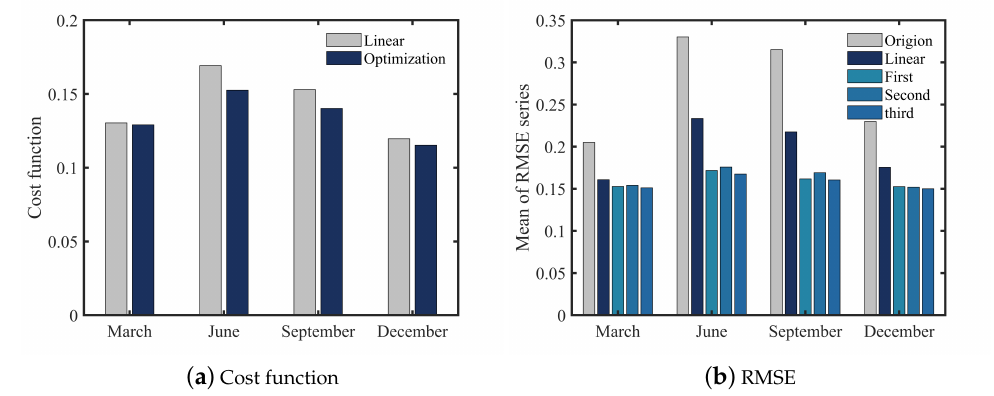
Figure 13. Verification of design methods based on a single